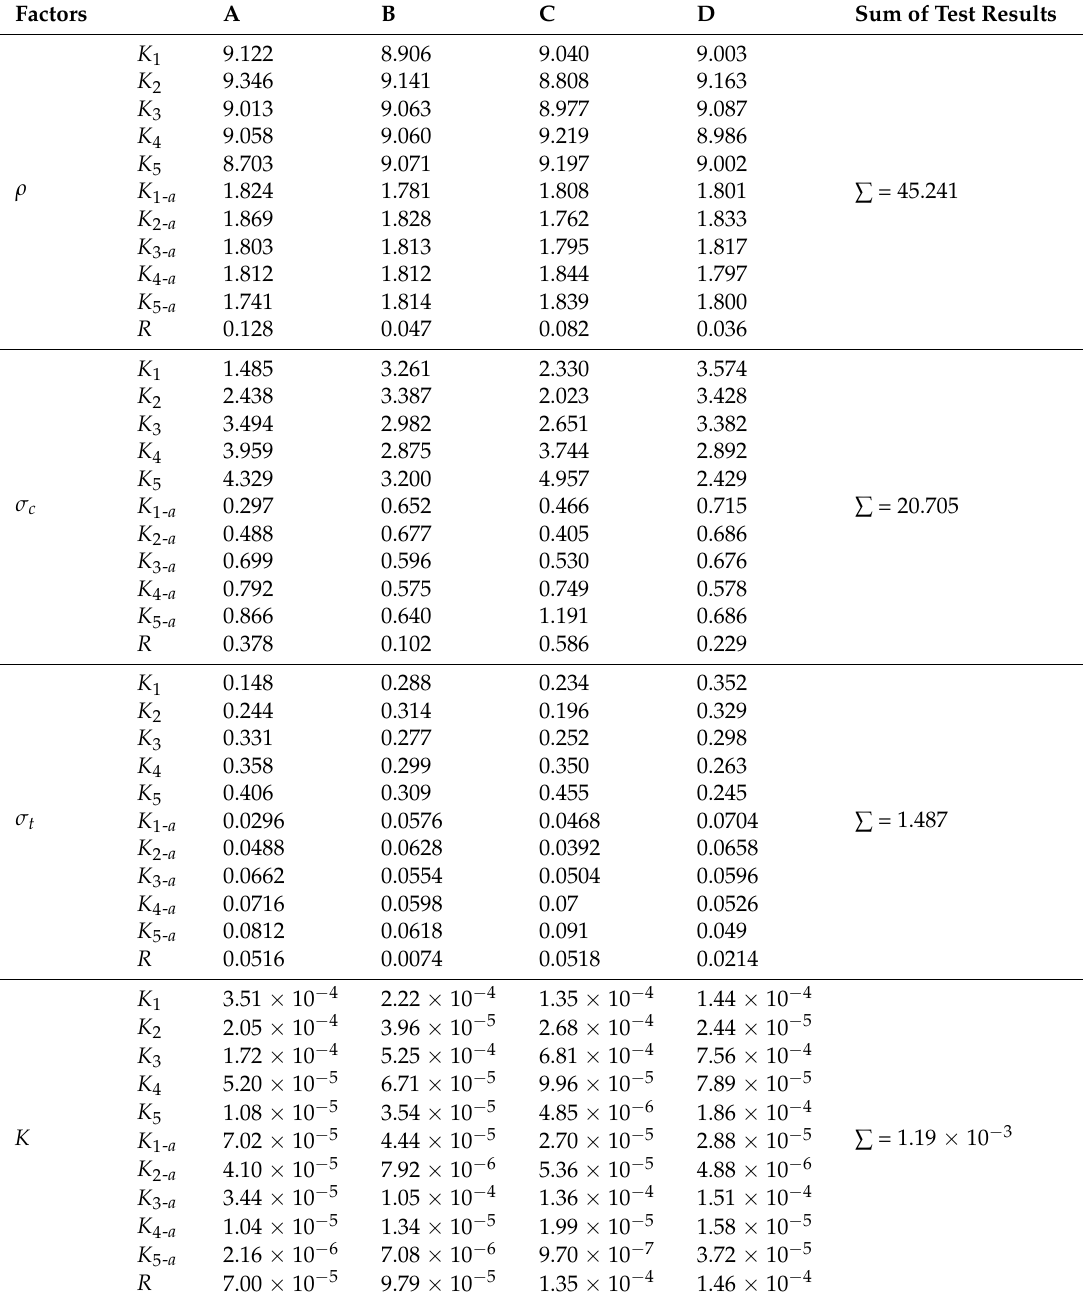
Table 4. The range analysis of the parameters of similar-materials in the orthogonal test.